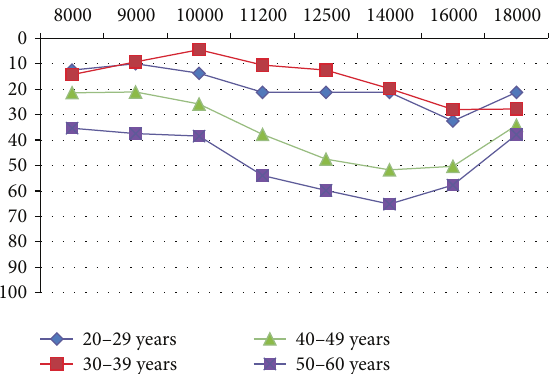
Figure 3: Hearing threshold with ultra high-frequency audiometry, within the age range of the study population with RA. Arithmetic means ( 𝑦 -axis: intensity, dB; 𝑥 -axis: frequency, Hertz or Hz). RA: rheumatoid arthritis.